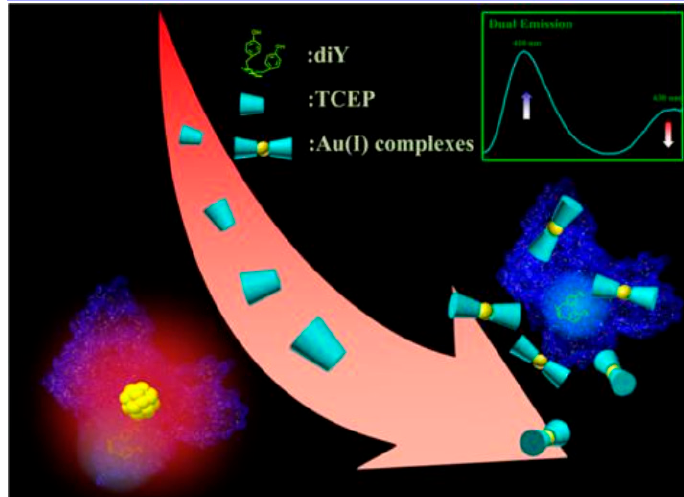
Figure 5. Tris (2-carboxyethyl)phosphine (TCEP) etching-induced quenching of red fluorescence emission of bovine serum albumin (BSA)-protected AuNCs and enhancing of the blue fluorescence emission of the dityrosine (diTyr) residues of the BSA ligands for detecting TCEP. Adapted with permission from Reference [61] Copyright (2016) American Chemistry Society.